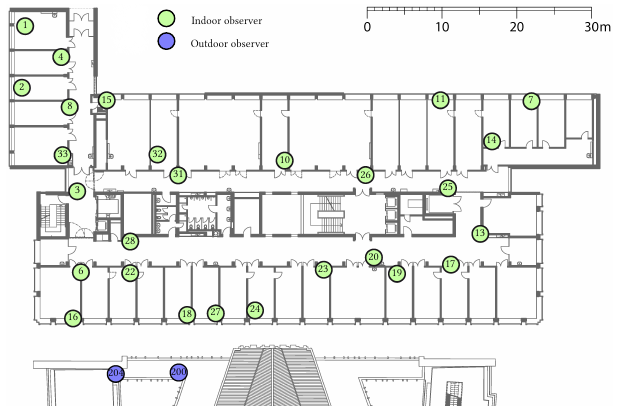
Figure 7. The deployment of sensor nodes in FlockLab.